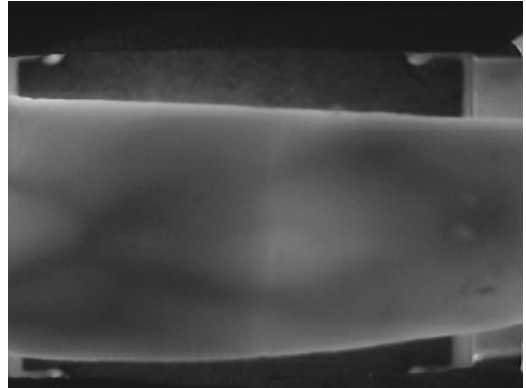
Figure 2. SDUMLA-HMT finger vein imaging map.